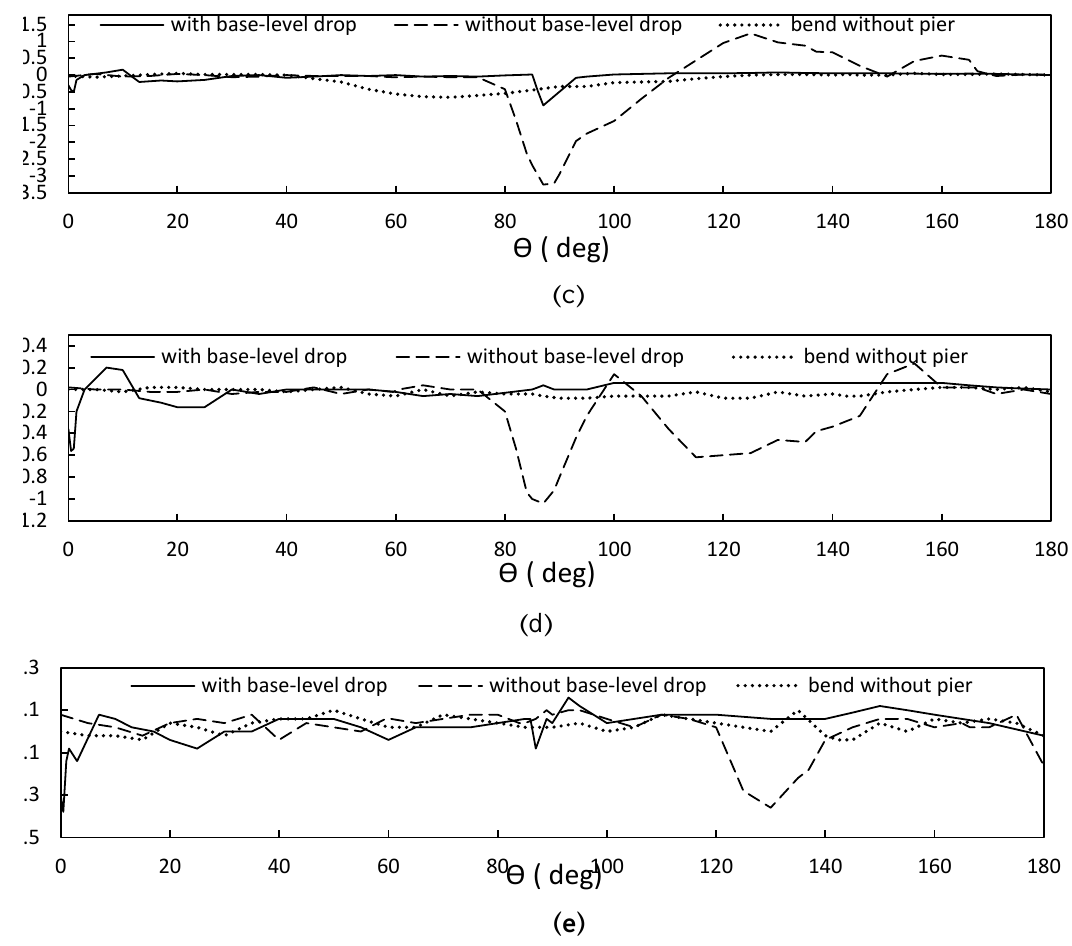
Figure 10. longitudinal sections at distances of a) 5, b) 25, c) 50, d) 75, and e) 95% of the channel width from the inner